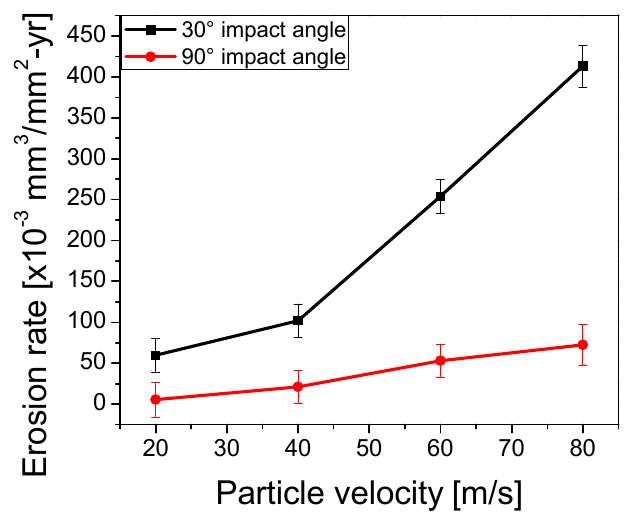
Figure 5. The erosion rate vs. particle speed for 30° and 90° impact angles.